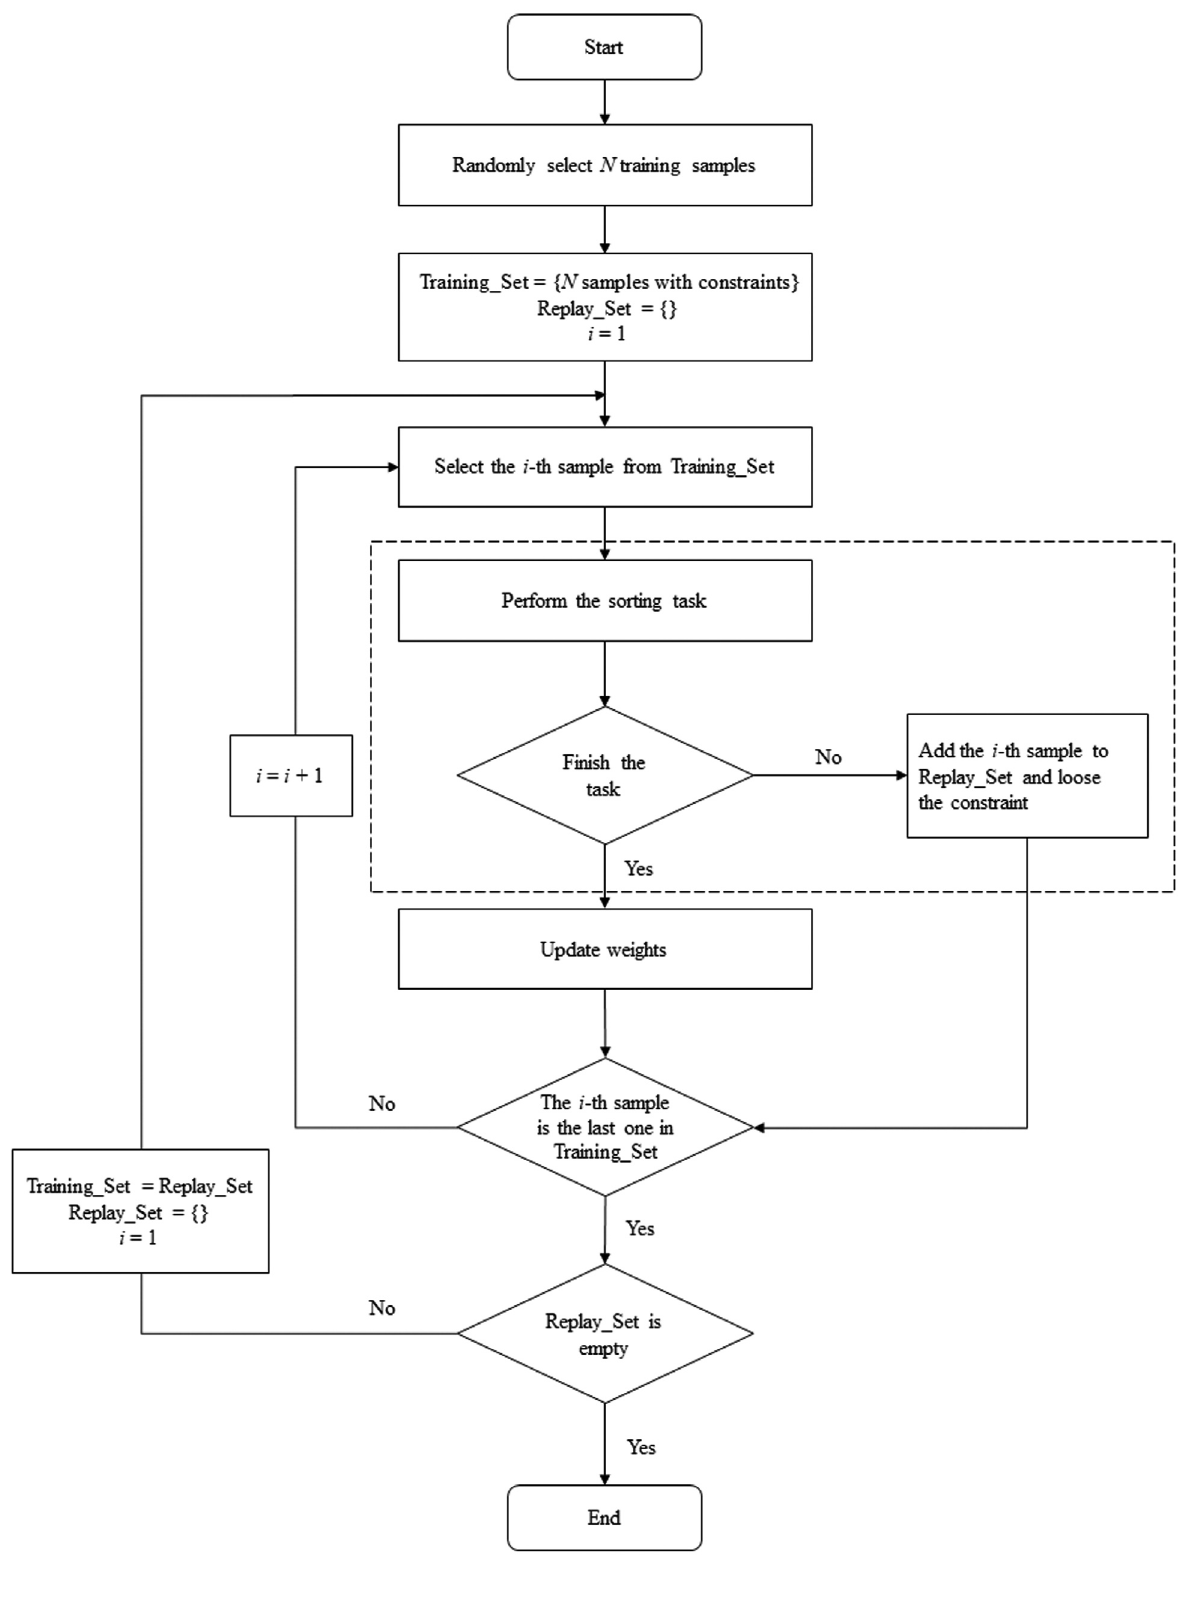
Fig. 1. Training flowchart where the dashed rectangle represents the goal­driven